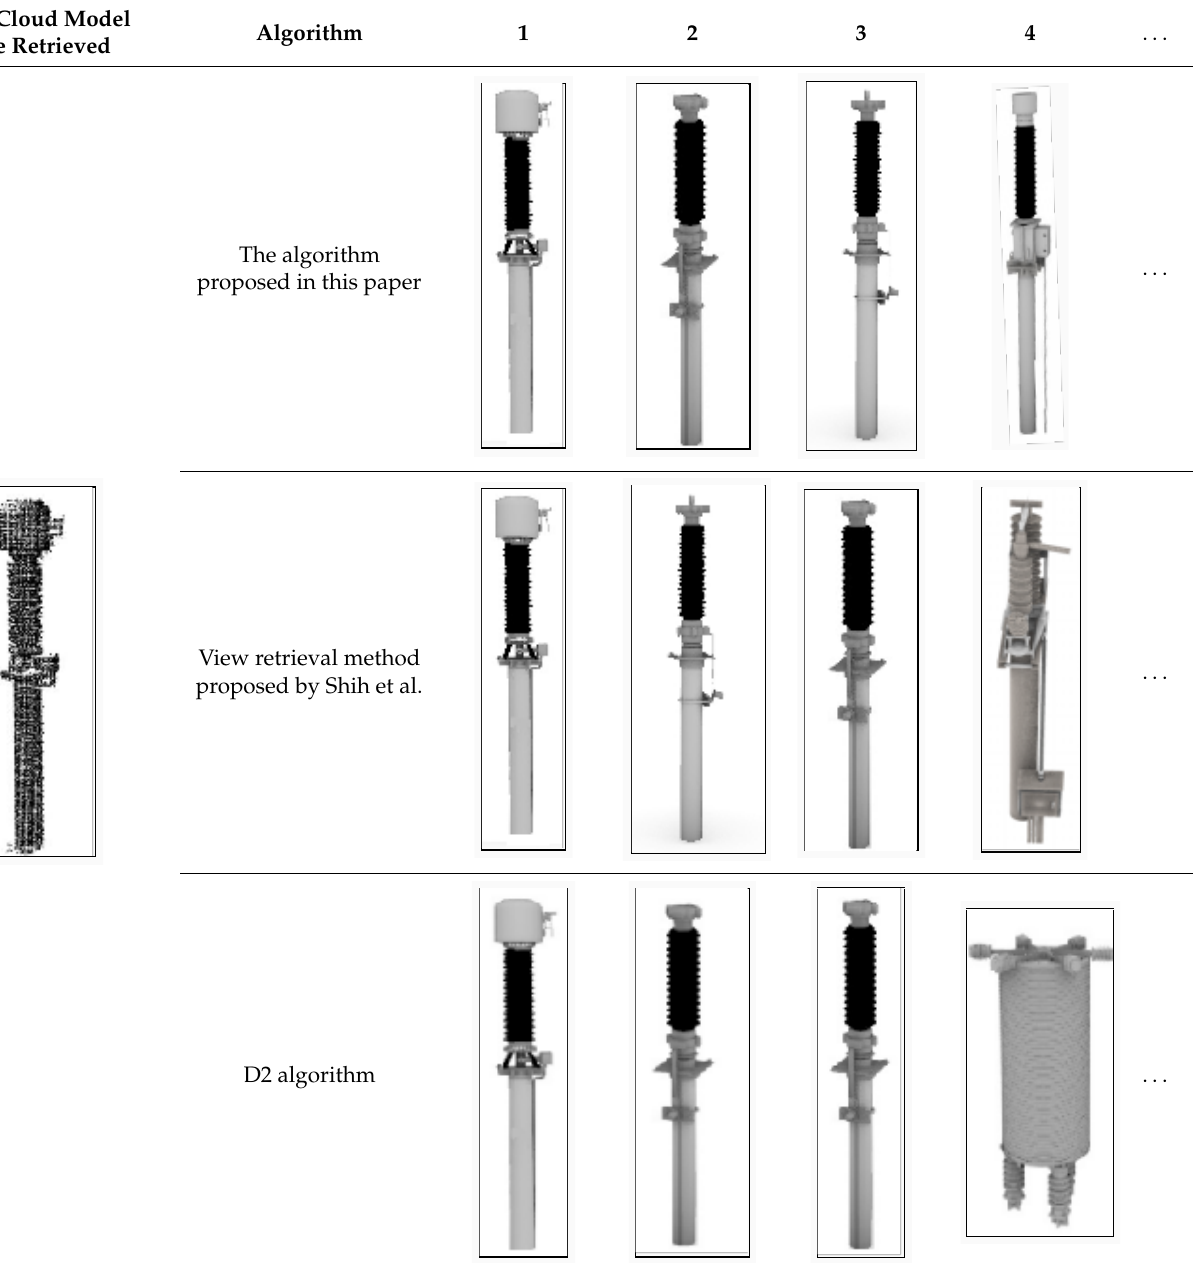
Table 3. The algorithm proposed in this paper, the D2 algorithm, and the model screening results of the two-dimensional image proposed by Shih et al. [16].